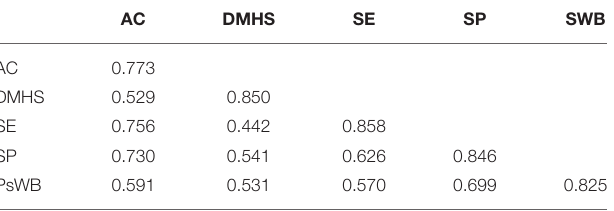
TABLE 4 | Fronell and Larcker